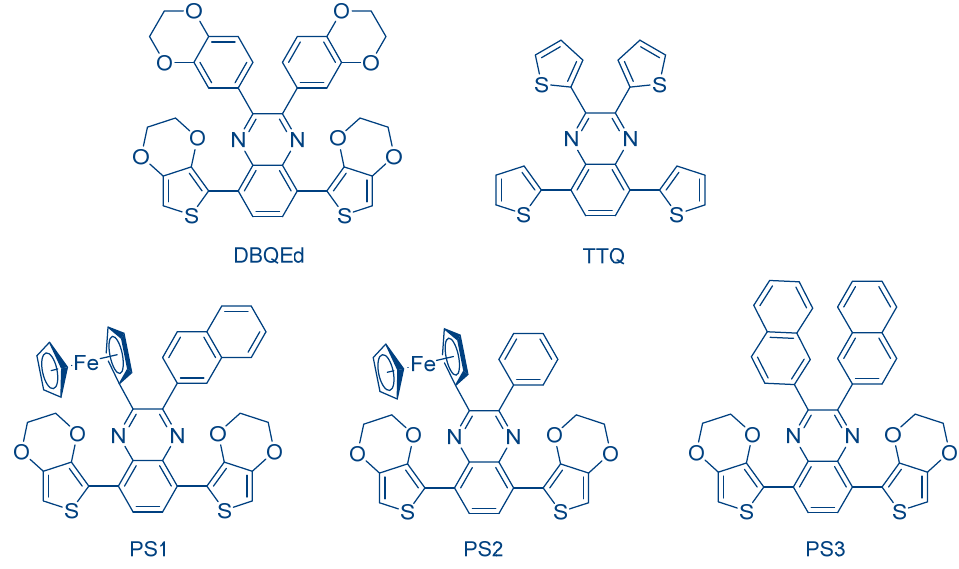
Figure 22. Chemical structures of quinoxalines absorbing at long wavelengths.